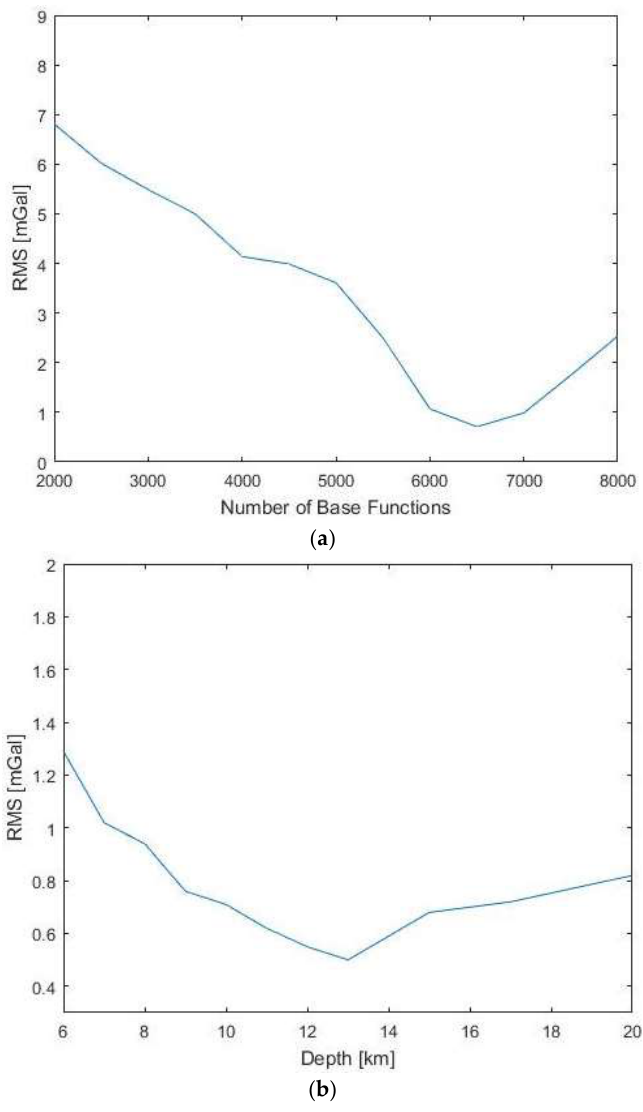
Figure 5. The variation of the RMS of discrepancies between the predicted and observed gravity anomalies at the control points versus the number of RBFs ( a ), versus the depth of RBFs ( b ).